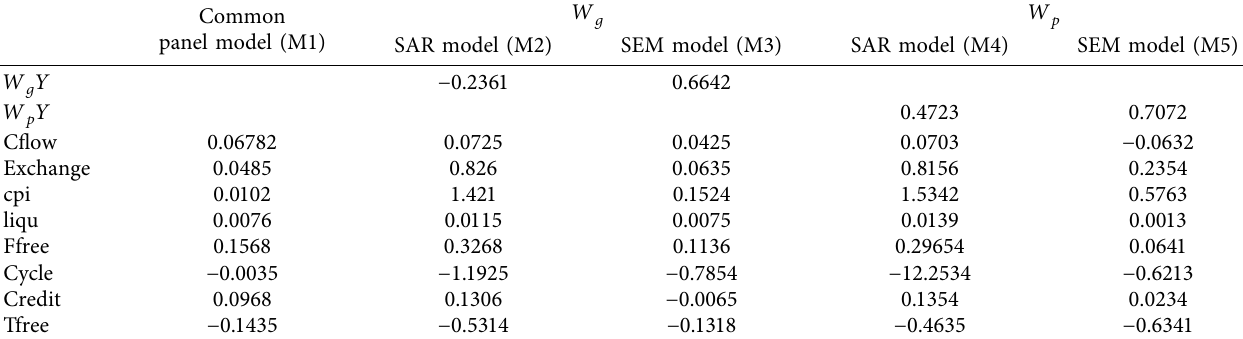
Table 6: Normal panel model and economic spatial weight matrix model of geographic and political